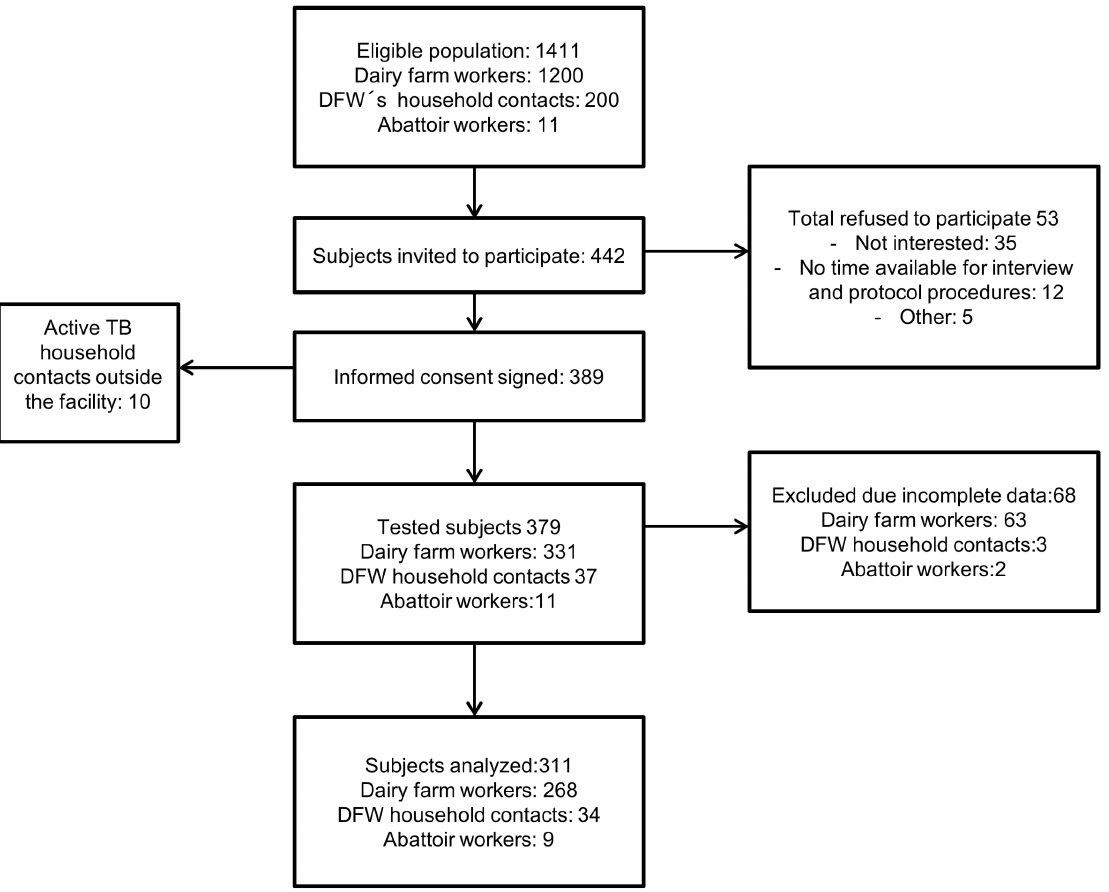
Figure 1. Flow chart of enrollment.